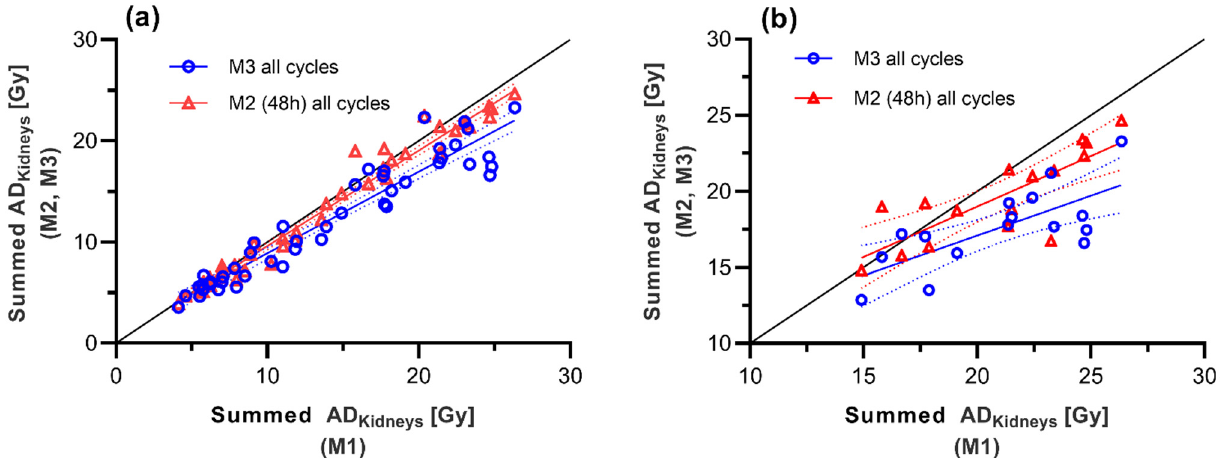
Figure 5. Correlation of the estimated absorbed dose of the kidneys calculated by using M1 ( x -axis) vs. M2 and M3 ( y -axis) for all cycles ( a ) as well for the sub-group of patients having received all 6 cycles ( b ). The dotted line represents the line of identity.